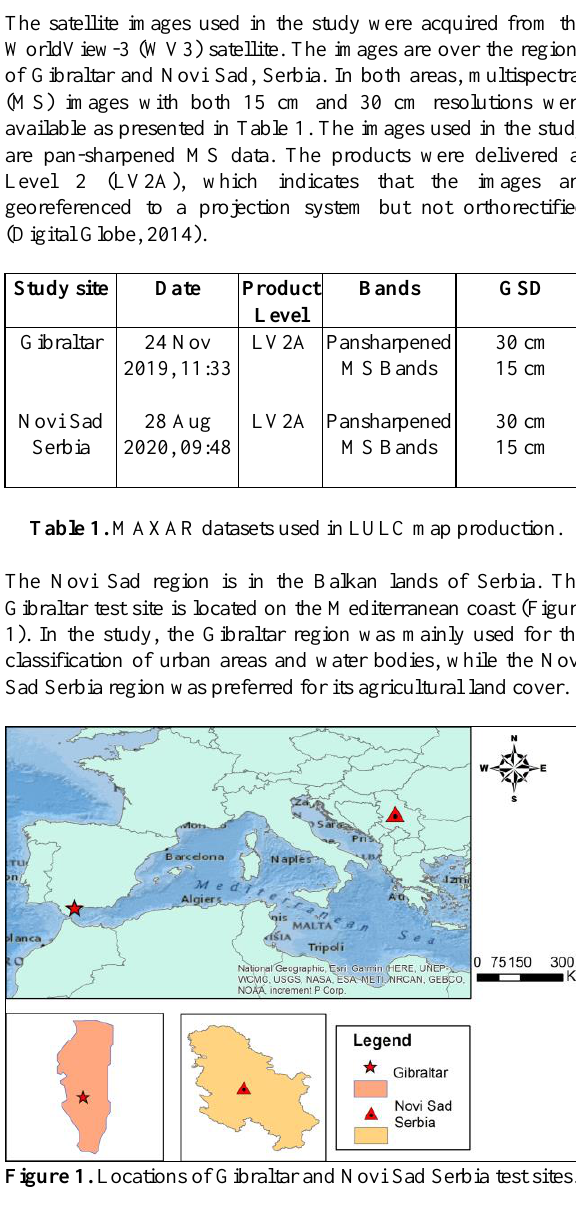
Figure 2. The overall workflow of the study.